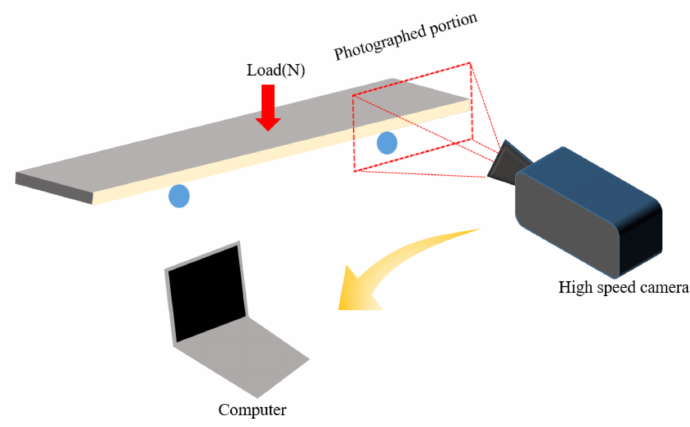
Figure 4. ML sensor system configuration and image acquisition.